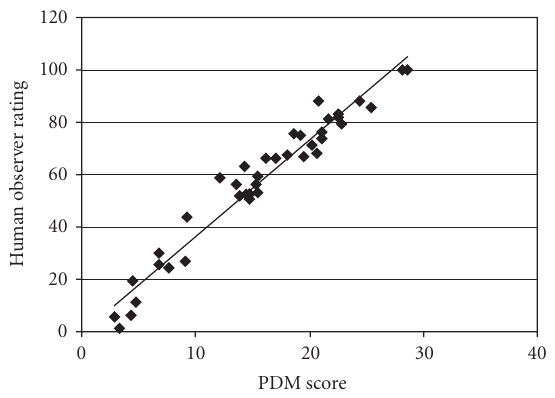
Figure 4: For the human subject evaluation experiment shown in Figure 3(a), normalized human subject ratings are plotted as a function of PDM score. Data were fit with y = mx + b , where m = 3 . 69 + − 0 . 27 and b = − 0 . 48 + − 4 . 78, giving R = 0 . 97.